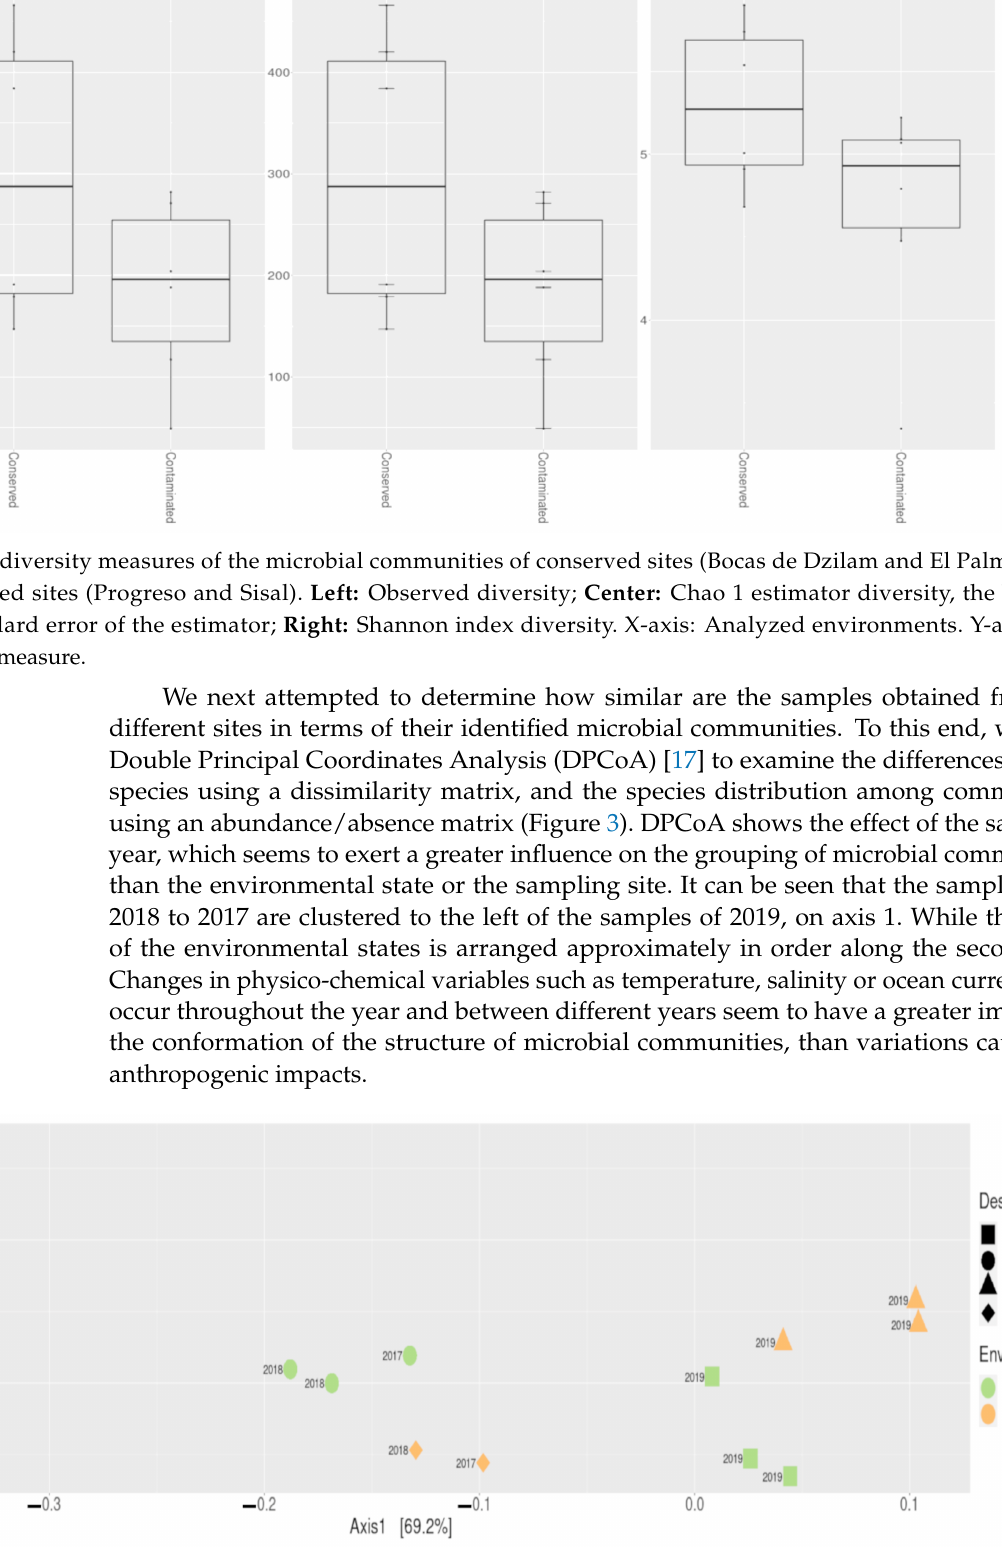
Figure 3. DPCoA of contaminated (Progreso and Sisal) and conserved (Dzilam and El Palmar) locations. Scatterplot of the first two principal axes of the DPCoA. Each geometric figure represents an individual sample, square: Bocas de Dzilam; circle: El Palmar; triangle: Progreso; diamond: Sisal. Each color represents an environmental state; green: conserved; orange: